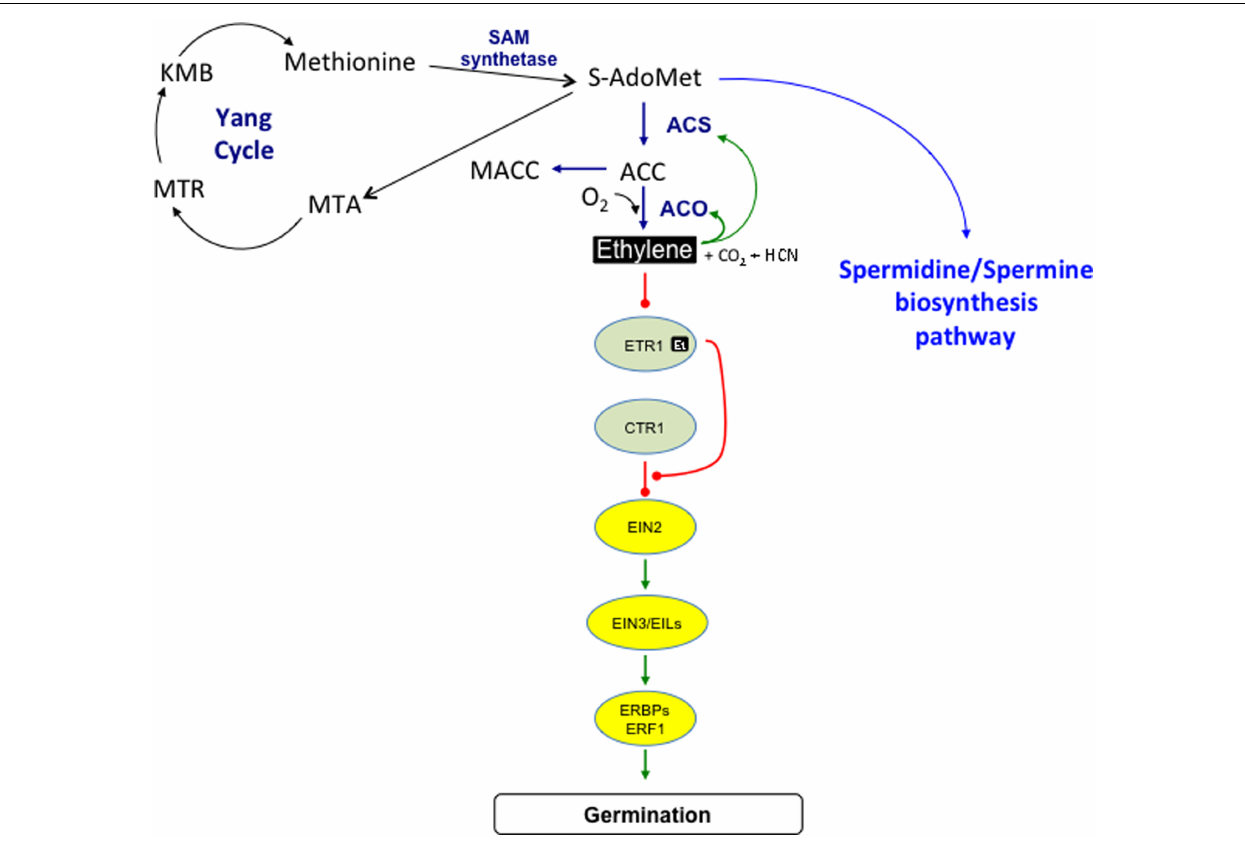
FIGURE 1 | Ethylene biosynthesis and signaling pathways. S -adenosyl methionine ( S -AdoMet) is synthesized from methionine by the SAM synthetase, it is then converted to 1-aminocyclopropane-1-carboxylic acid (ACC) by the ACC synthase (ACS), 5-methylthioadenosine (MTA) being a by-product. MTA is recycled to methionine through the Yang Cycle by successive enzymatic reactions involving different intermediates among which 5-methylthioribose (MTR) and 2-keto-4-methylthiobutyrate (KMB). S -AdoMet is also the precursor of the spermidine/spermine biosynthesis pathway. Ethylene production results from the ACC oxidation catalyzed by the ACC oxidase (ACO) that also generates carbon dioxide and cyanide. Malonylation of ACC to malonyl-ACC (MACC) reduces ACC content and consequently ethylene production.